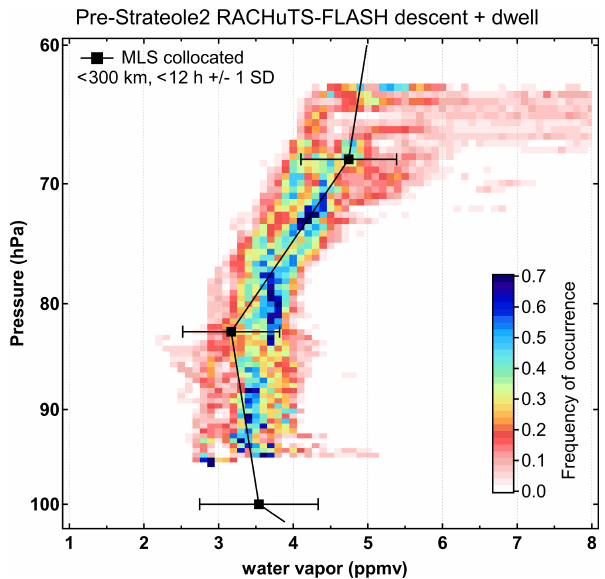
Figure 7. Comparison of the frequency of FLASH-B water vapor measurements from the 44 descent profiles with the average of the closest Microwave Limb Sounder water vapor measurements within 12h of each profile. The positive bias of FLASH-B at pressures below 67hPa is attributed to outgassing of water vapor from the balloon and